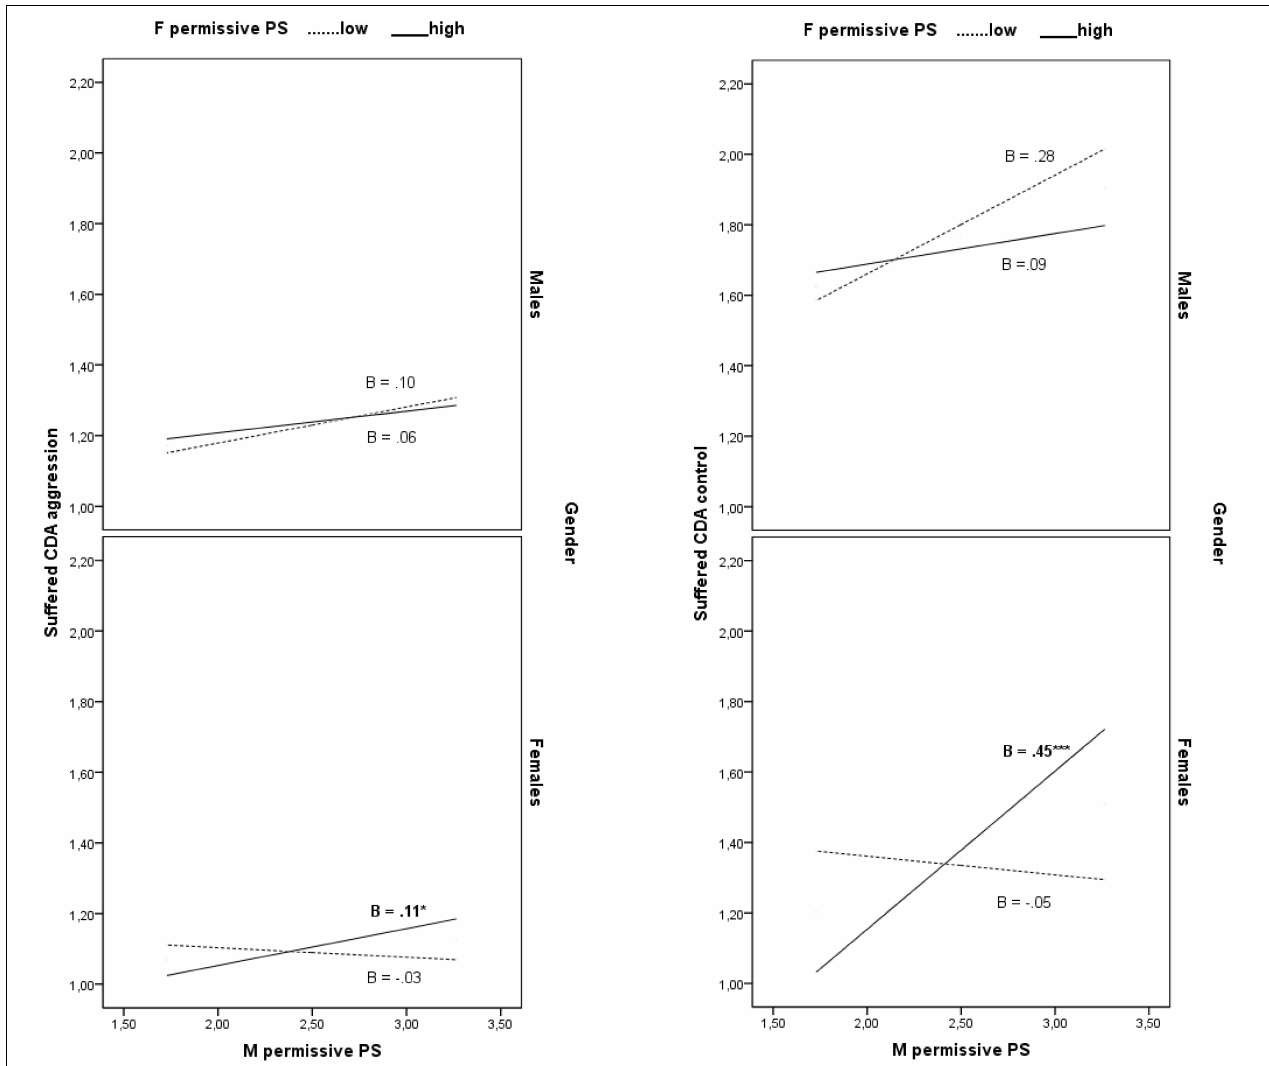
FIGURE 3 | The conditional effects of mother permissive parenting style on suffered cyber dating aggression and control as a function of father permissive parenting style and child gender. * p < .05, *** p < .001. M, mother; F, father; PS, parenting style; CDA, cyber dating